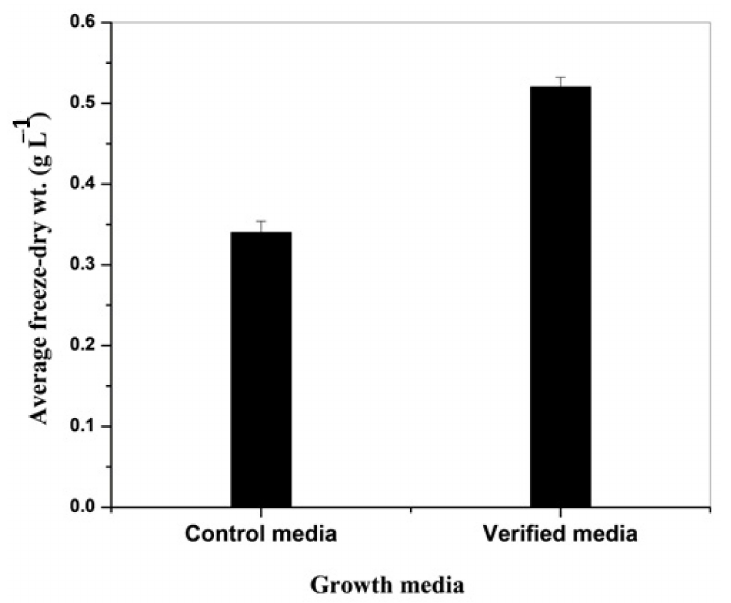
Figure 2. Average freeze-dry weight of Anabaena variabilis grown in control and verified (optimized) Navicula